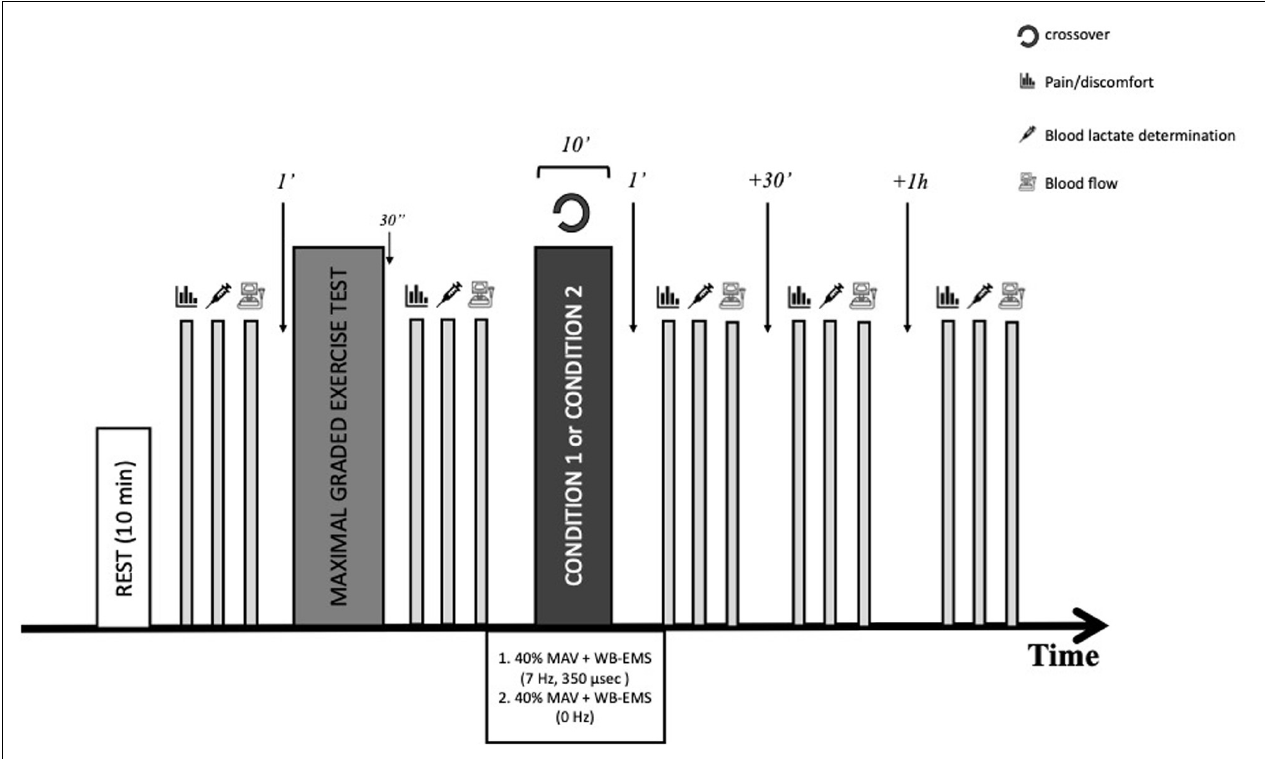
FIGURE 2 | Study protocol timeline (BLa, blood lactate accumulation; MAV, maximum aerobic velocity).